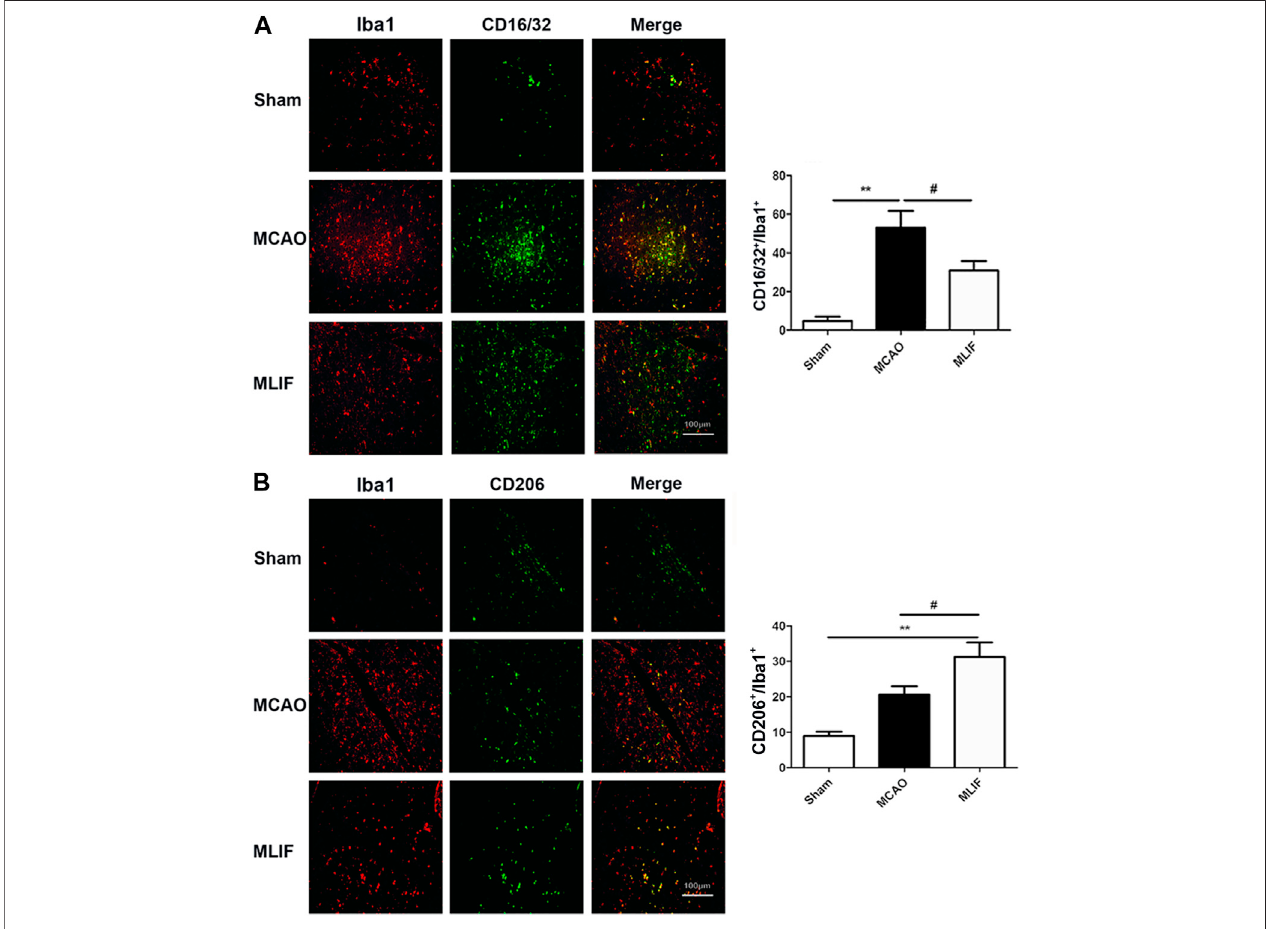
FIGURE1| MLIFpromotedmicrogliapolarizationtowardtheM2phenotypeinthemiceMCAOmodel. (A,B) Doubleimmunostainingwasusedtoassessmicroglia (Iba1 + ) and an M1-associated marker (CD16/32 + ) or an M2-associated marker (CD206 + ) in mouse brain slices. The summarized bar graphs showed the colocalization rate of CD16/32 or CD206 with the Iba1 number in the ischemic region in the cortex. Scale bar: 200 μ m. Data are expressed as the mean ± SEM. N (cid:1) 6. ** p < 0.01, vs Sham group, # p < 0.05 vs MCAO group.